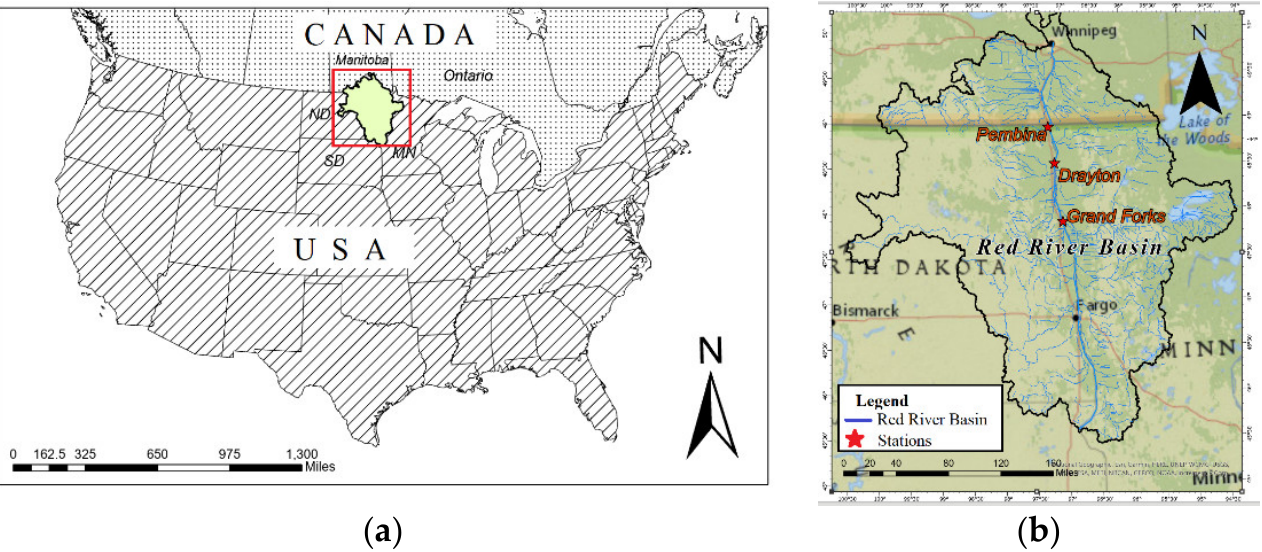
Figure 1. ( a ) Location of Red River basin; ( b ) location of USGS stations on Red River in Pembina, Drayton, and Grand Forks.